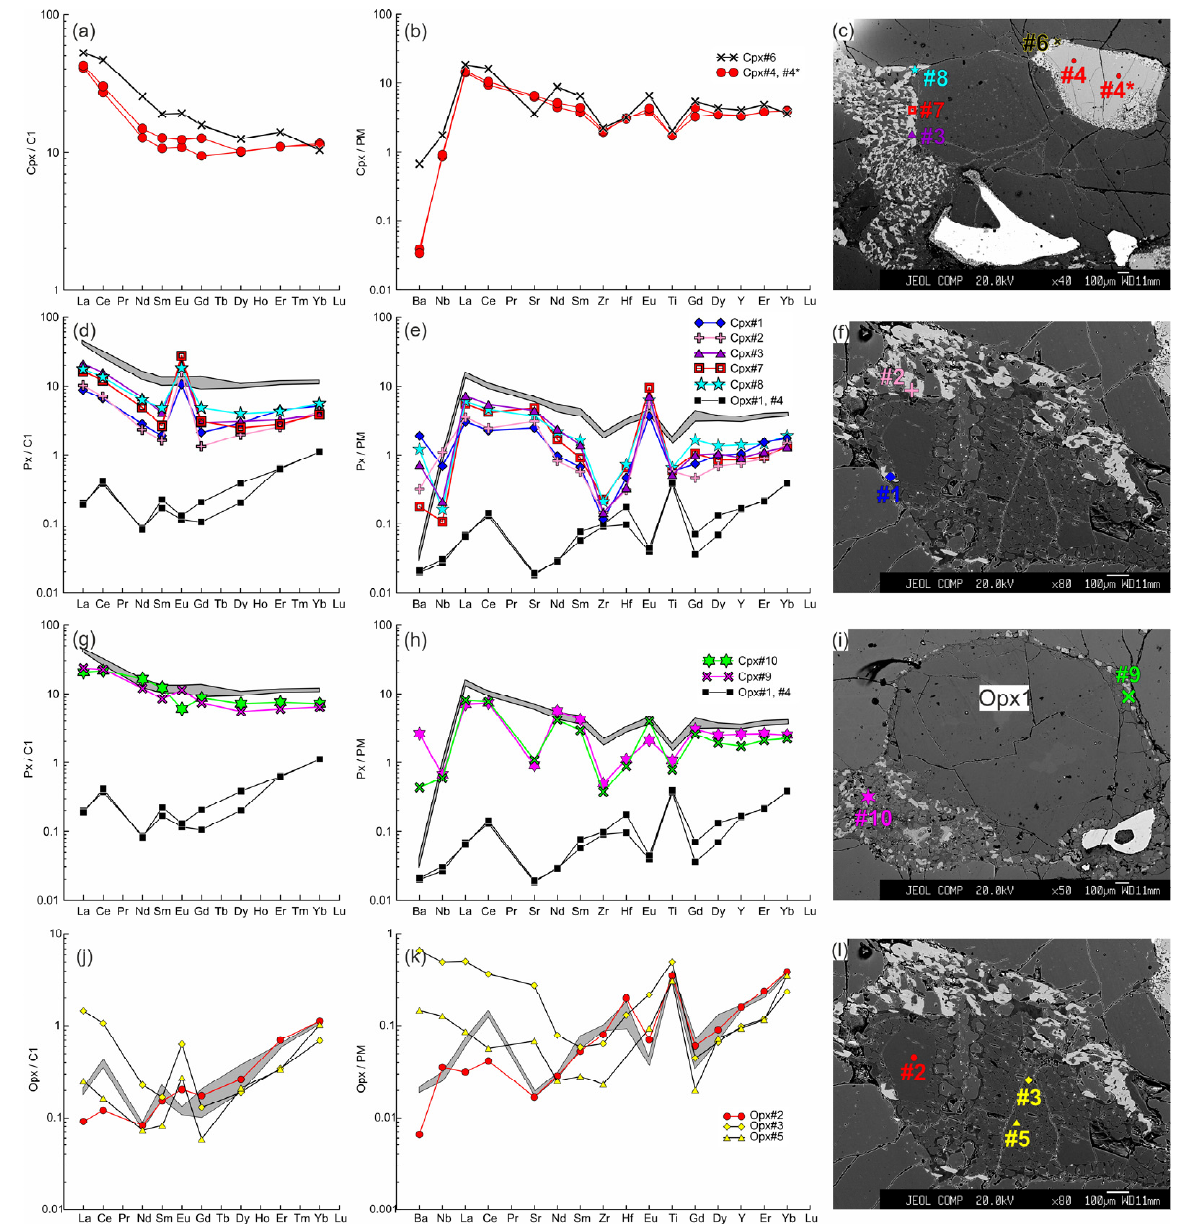
Figure 11. The trace element composition of the clino- and orthopyroxenes from sample HD5 normalized to the CI chondrite [31] ( a , d , g , j ) and primitive mantle [31] ( b , e , h , k ). ( a – c ) Cpx1 (#4, #4*) with a wide reaction zone of Cpx2 (#6) near the contact with basanite. ( d – f ) Cpx3 (#1, #2 in ( f ), #3, #7, #8 in ( c )) from the orthopyroxene reaction zone, and primary orthopyroxene (Opx#1, #4; the location is beyond the area shown on the photo). In ( d , e , g , h ), the gray field shows the compositions of Cpx1 (#4, #4*). ( g – i ) Cpx3 (#9, #10) from the thin reaction zone of Opx1 inside the xenolith. ( j – l ) Orthopyroxene reaction zone of the second type, with unreacted Opx1 (#2) and secondary Opx2 (#3, #5). The gray field in ( j , k ) shows the compositions of the primary orthopyroxene (#1,